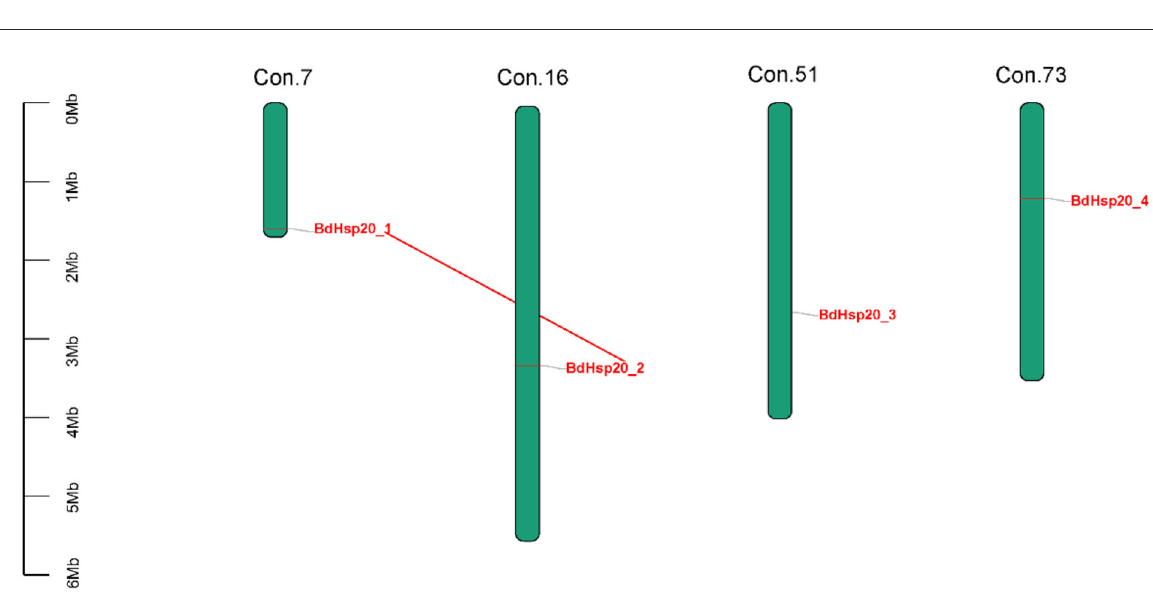
BdHsp20 gene editing reduced the